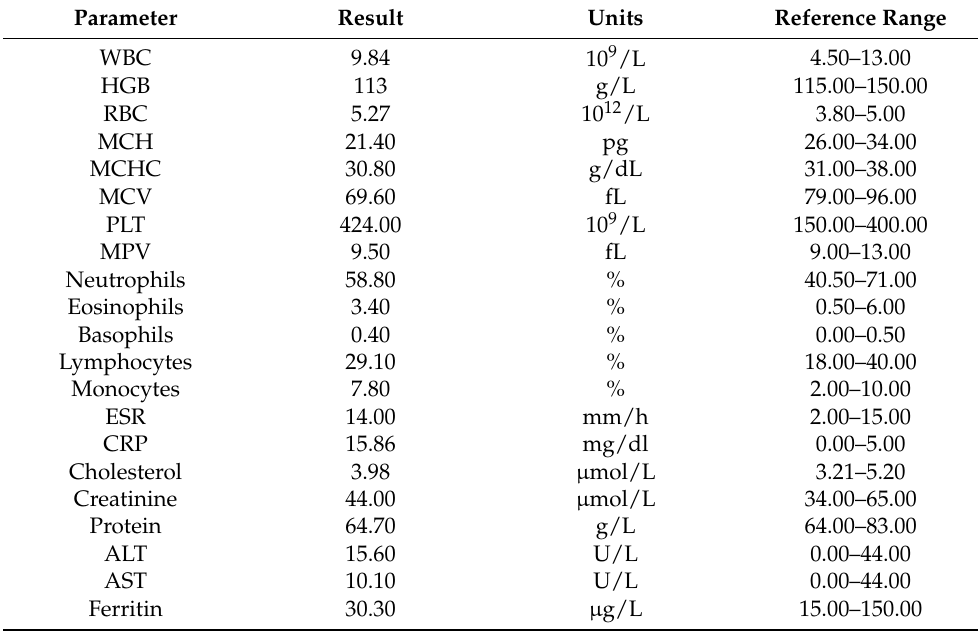
Table 1. General laboratory results at the hospital